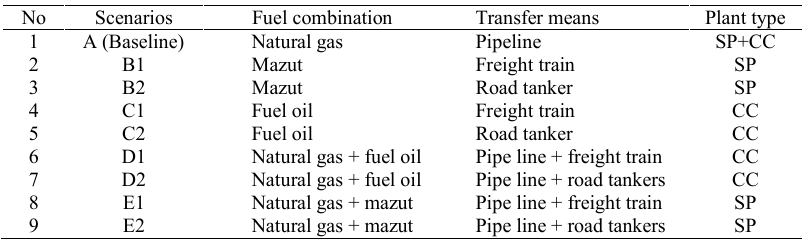
Table 1: Plant type, fuel type and fuel transfer scenarios description